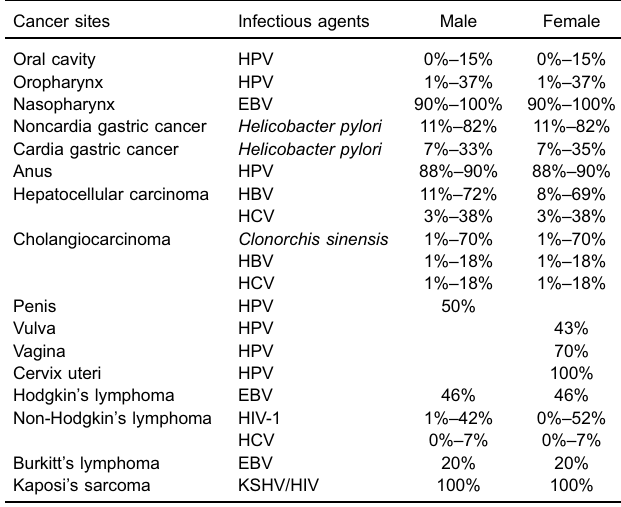
Table 4. The PAFs of infectious agents and cancer sites in 13 Asian countries, by gender Cancer sites Infectious agents Oral cavity